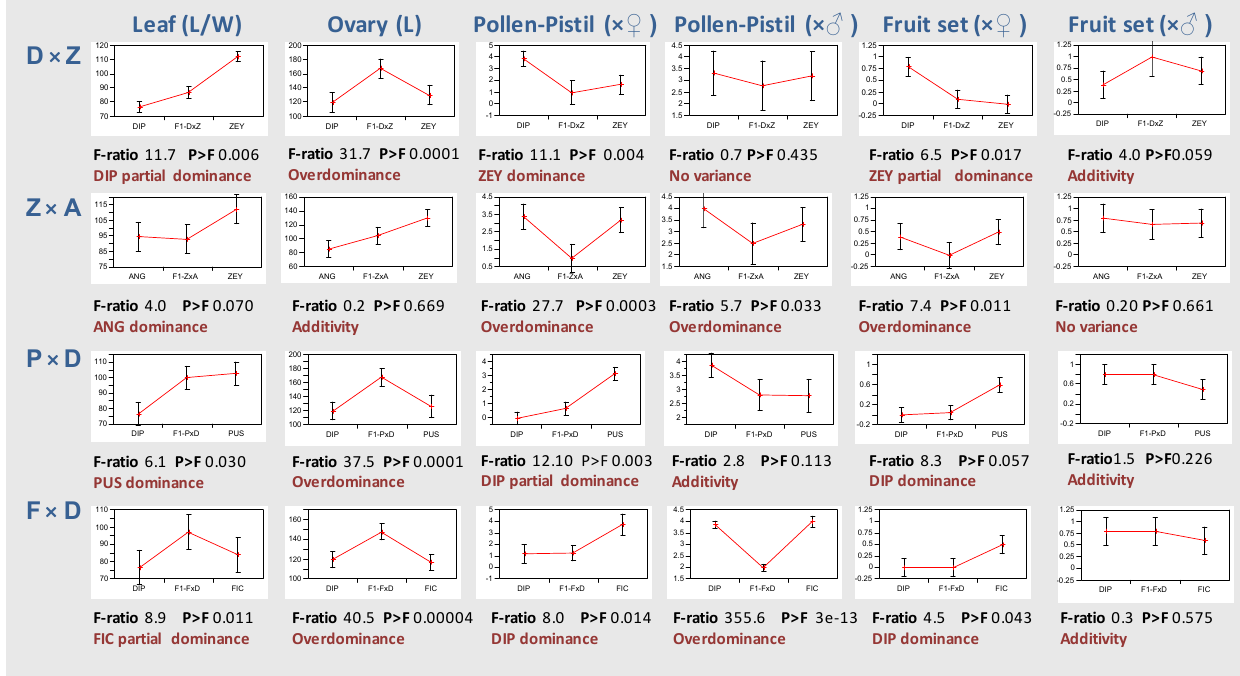
Figure 8. Gene action in interspecific F 1 hybrids. Least Squares Means for different traits were estimated to compare F 1 hybrids with their parents. LS Means plots for 4 F 1 hybrids (rows) and 6 traits (columns) are shown. Traits include leaf length/width ratio (%) and ovary length (mm), as well as pre-zygotic pollen-pistil interaction (CI levels 5–8 transformed into a 0–4 scale, see Section 4) and fruit set (expressed as decimals) in backcrosses with seed parent (× ♀ ) and male parent (× ♂ ). Each plot represents LS means and their standard errors for the parents and the resulting F 1 hybrid. F-ratios and corresponding p -values for the means contrasts between the F 1 hybrids and the expected mid-value from parents are also